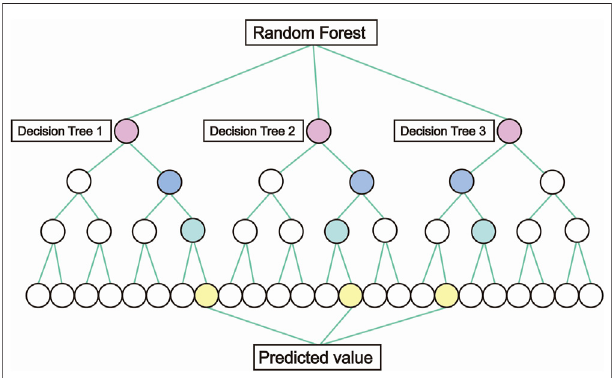
FIGURE 2 | Schematic diagram of the random forest structure.